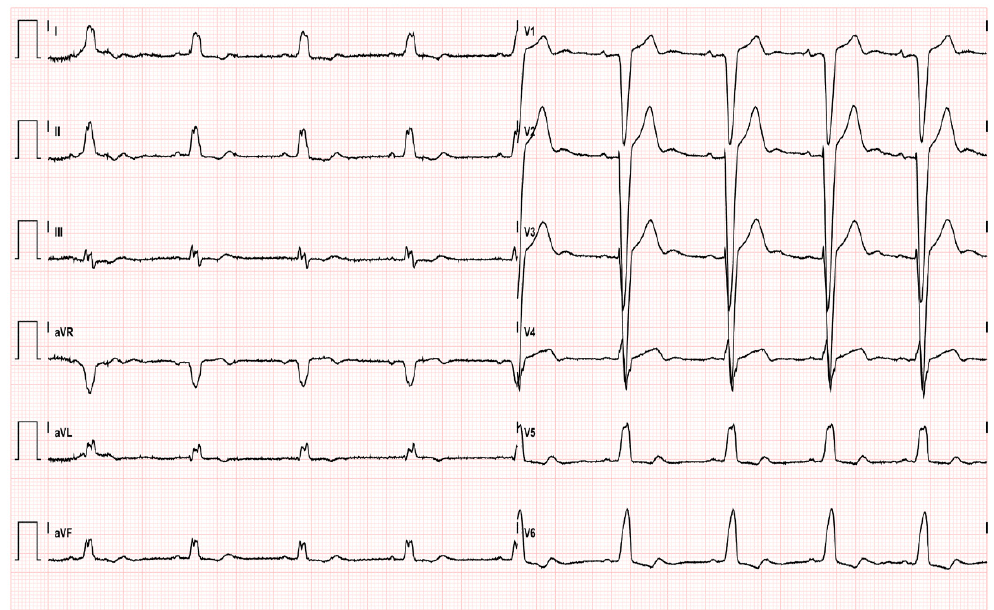
Figure 3. EKG after emergent coronarography; sinus rhythm, heart rate 55 bpm, LBBB, ST normalization.